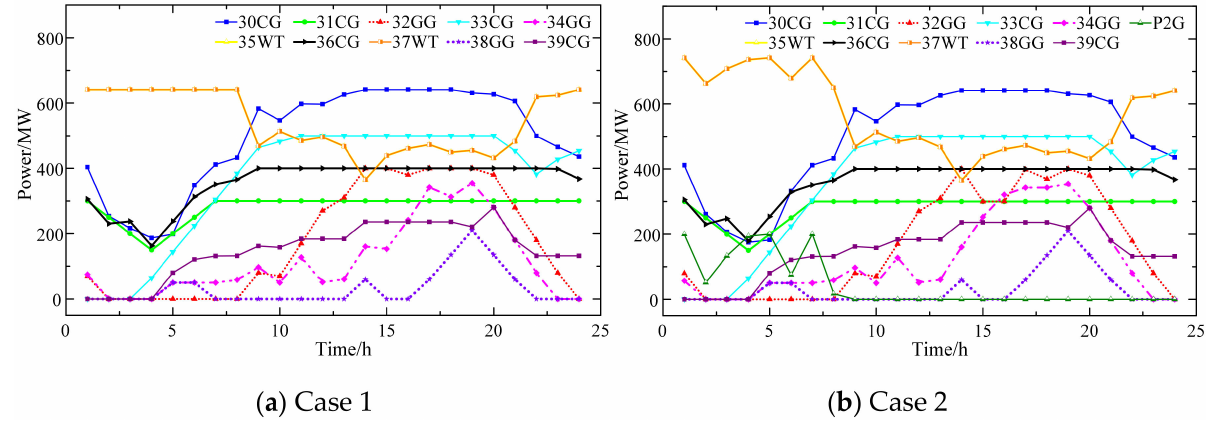
Figure 7. Power output of each unit.